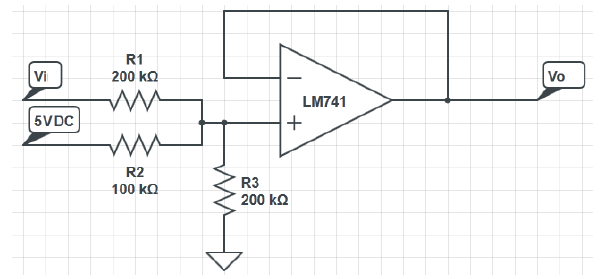
Figure 4. Schematic diagram of signal conditioning circuit